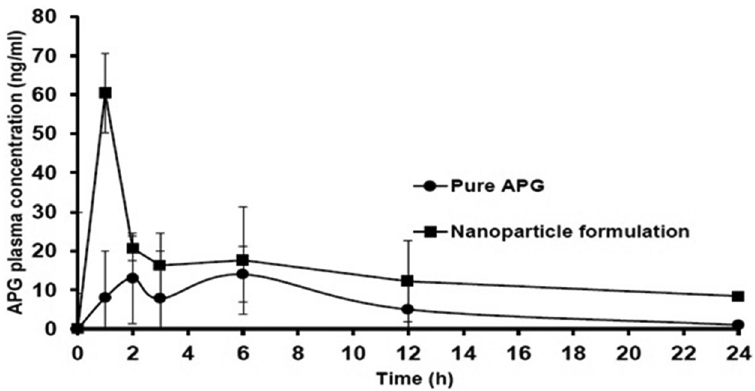
Figure 8: Drug concentration – time pro fi le curve of APG after oral administration of its optimized nanoparticle formulation in comparison to the pure drug.